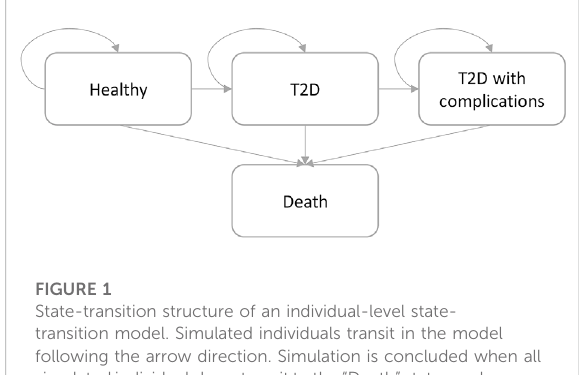
FIGURE 1 State-transition structure of an individual-level state- transition model. Simulated individuals transit in the model following the arrow direction. Simulation is concluded when